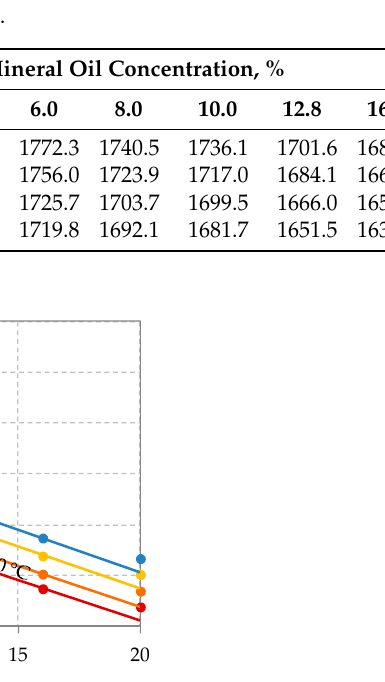
Figure 6. Capacitance C of a trimmer immersed in mineral oil and synthetic ester mixtures as a function of oil concentration for different temperatures. Table 4. Values of parameters a and b depending on temperature calculated based on data pre- sented in Figure 6.